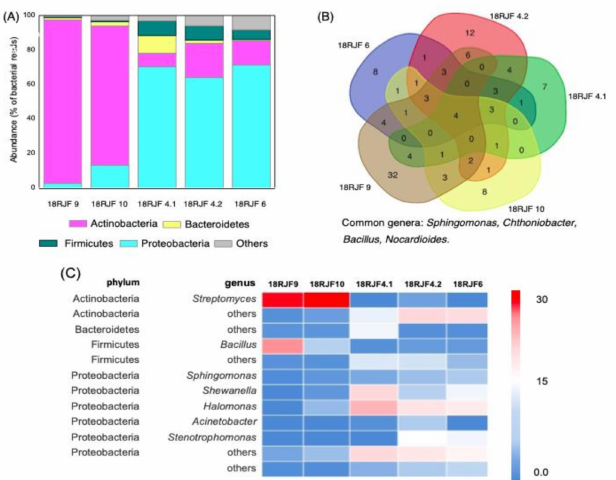
Figure 3. ( A ) Abundance of bacterial phyla in the communities isolated from the TS-1 jet fuel based on the sequencing of 16S rRNA libraries. The percentage of bacterial NGS reads corresponding to each phylum (of total prokaryotic reads) is shown. “Others” are unidentified sequences. ( B ) The number of common genera in the communities isolated from the TS-1 jet fuel based on 16S rRNA metabarcoding data analysis. ( C ) Frequency heatmap based on 16S rRNA sequencing. The color corresponds to the fraction of NGS reads in each